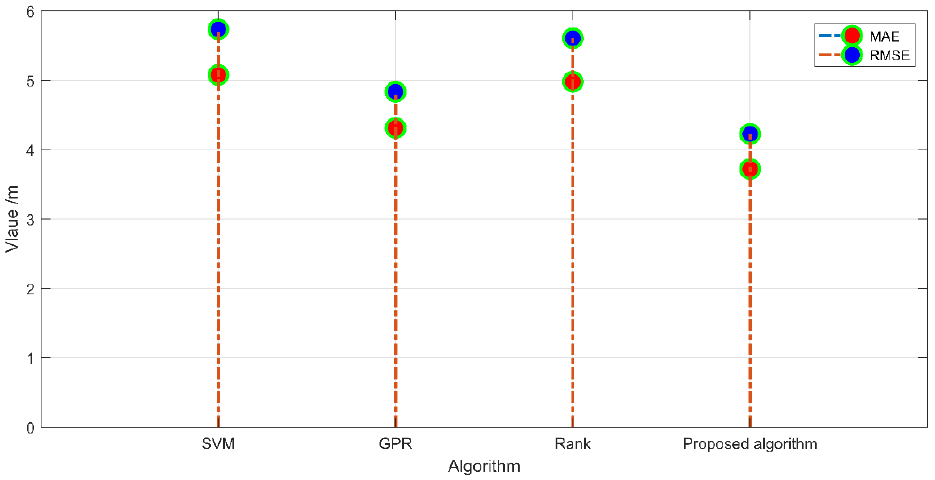
Figure 12. MAE and RMSE of SVM, GPR, rank, and the proposed algorithm.